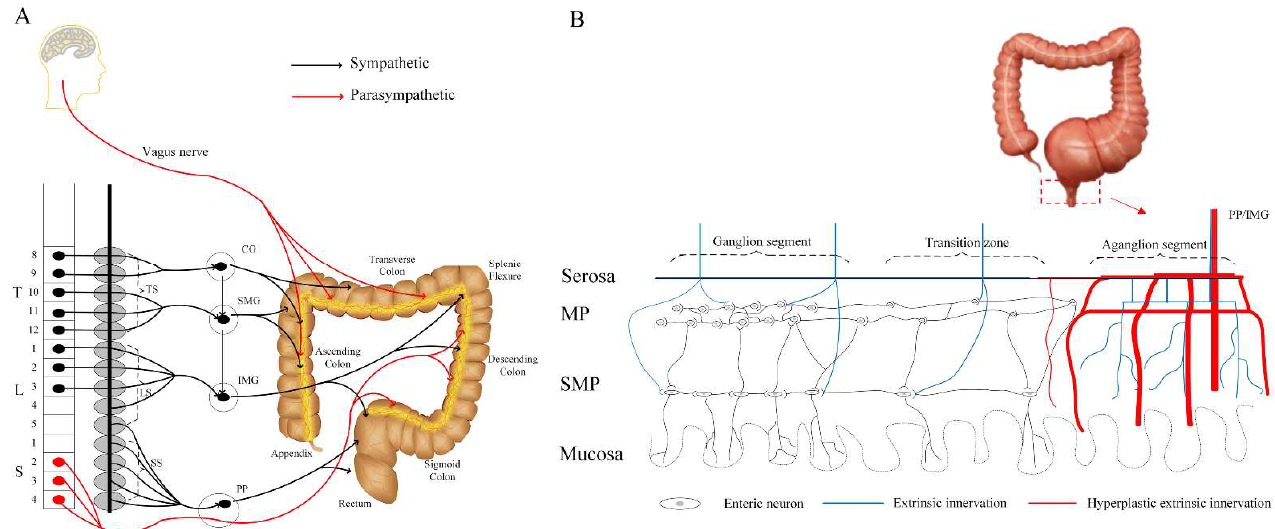
Figure 1. Intestinal innervation in the HSCR colon. ( A ) Intestinal innervation network. ( B ) Intrinsic nervous system and exogenous nerve fibers in the HSCR colon. Abbreviations: HSCR, Hirschsprung’s disease; T, thoracic vertebrae; L, lumbar vertebrae; S, sacral vertebrae; TS, thoracic spinal; LS, lumbar spinal; SS, sacral spinal; CG, celiac ganglion; SMG, superior mesenteric ganglion; IMG, inferior mesenteric ganglion; PP, pelvic nerve; ENS, enteric nervous system; MP, myenteric plexus; SMP, submucosal plexus.